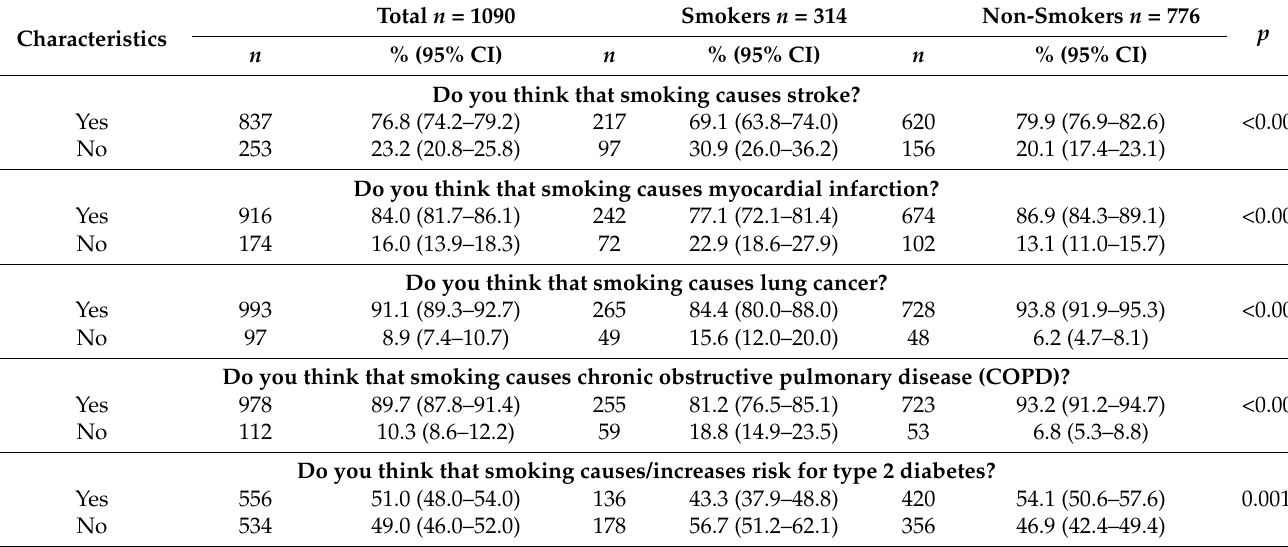
Table 2. Awareness of tobacco-related diseases by smoking status ( n =